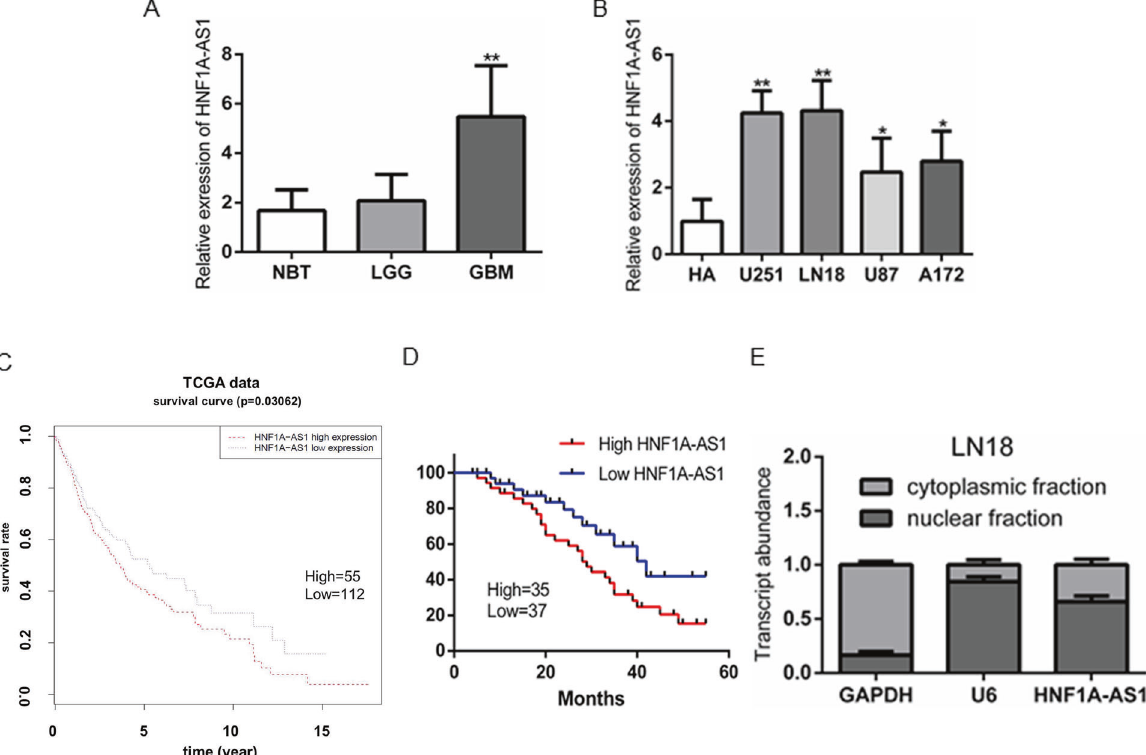
Fig. 1 HNF1A-AS1 was highly expressed in GBM. A RT-QPCR analysis of HNF1A-AS1 expression in normal brain tissues (NBT) ( n = 15), low- grade glioma tissues ( n = 41) and GBM tissues ( n = 72). ** P < 0.01 vs. NBT group. B RT-QPCR analysis the expression levels of HNF1A-AS1 in normal human astrocyte (HA) and four GBM cell lines (U251, LN18, U87 and A172). * P < 0.05, ** P < 0.01 vs. HA group. C In TCGA date, the overall survival rate of GBM patients with high (HNF1A-AS1-high, n = 55) and low (HNF1A-AS1-low, n = 112) expression of HNF1A-AS1 in tumor. D Kaplan – Meier analyses of the associations between HNF1A-AS1 expression level and overall survival of patients with human glioma in our department (The log-rank test was used to calculate P -values). ** P < 0.01 vs. low HNF1A-AS1 expression group. E Nuclear and cytoplasmic fractions of HNF1A-AS1 in GBM cell lysates were analyzed by